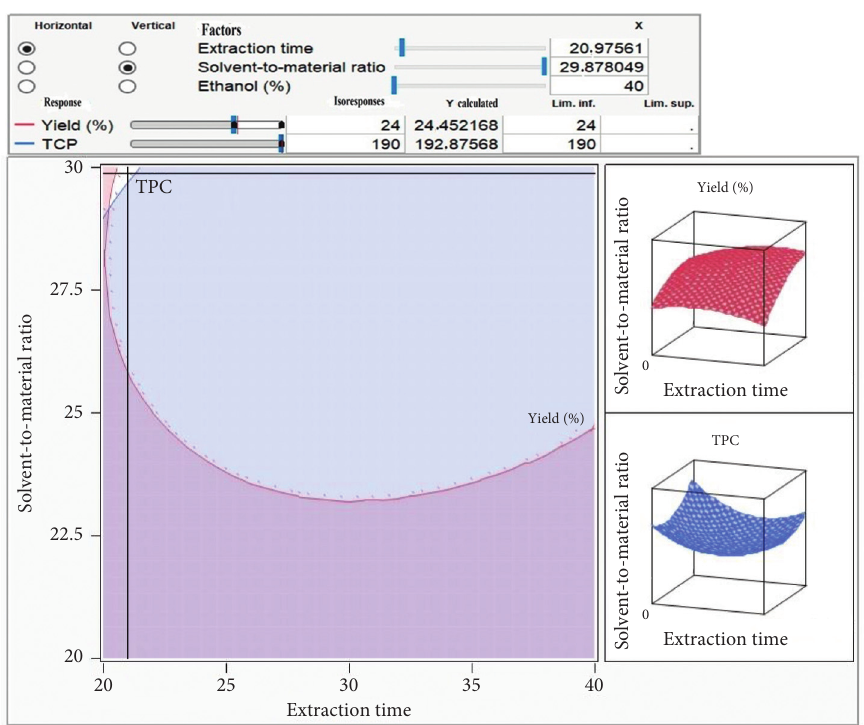
Figure 7: Isoresponse plot showing the precise operating conditions leading to the optimization of both yield and TPC responses, Table 6: Theoretical and experimental responses recorded for the selected operating conditions. Extraction conditions Concentration of ethanol